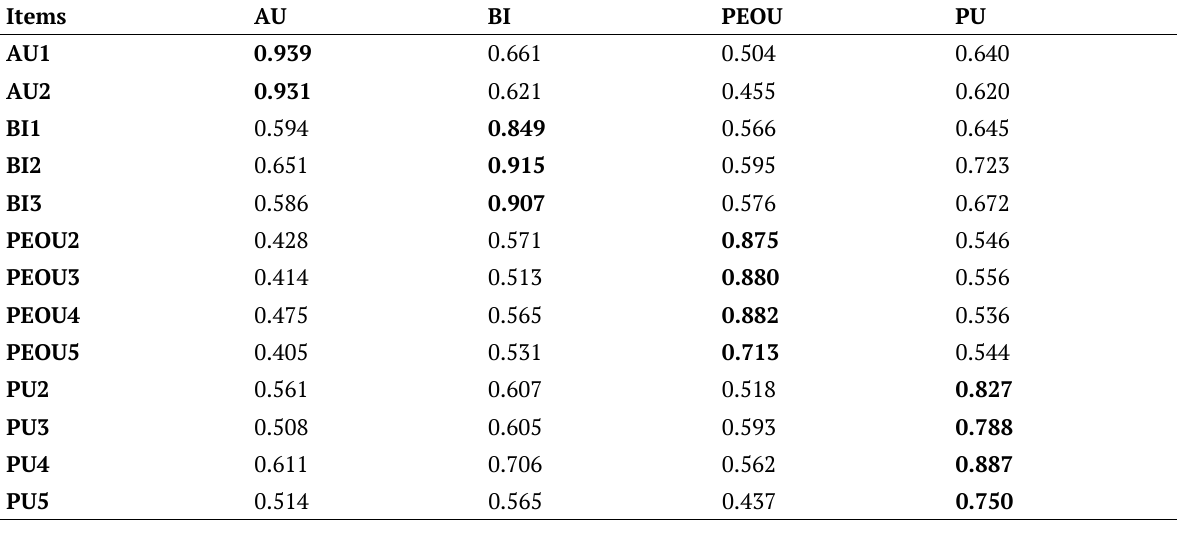
Table 4. Cross loading results